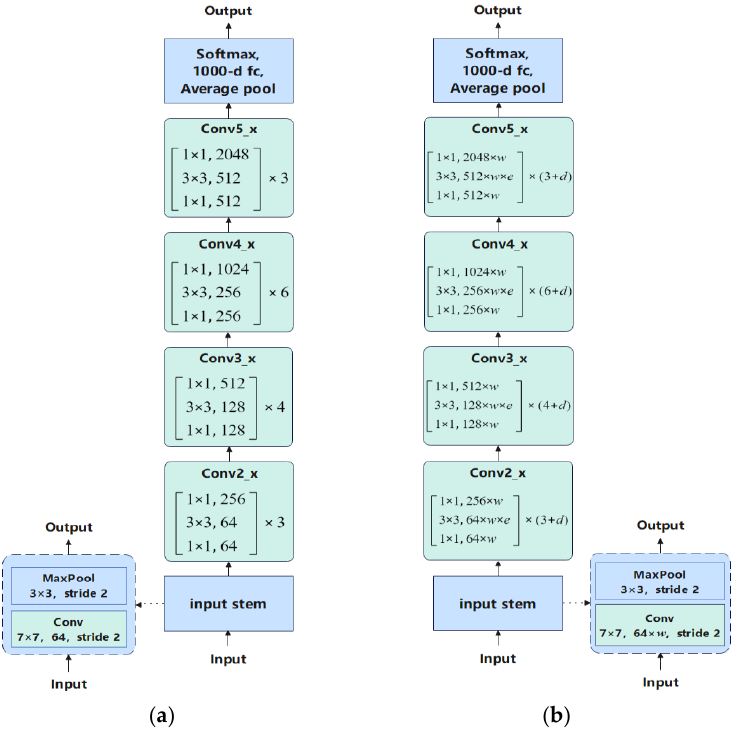
Figure 3. Comparison of Resnet50 and the search space: ( a ) Resnet50 structure; ( b ) Network structure of the search space.